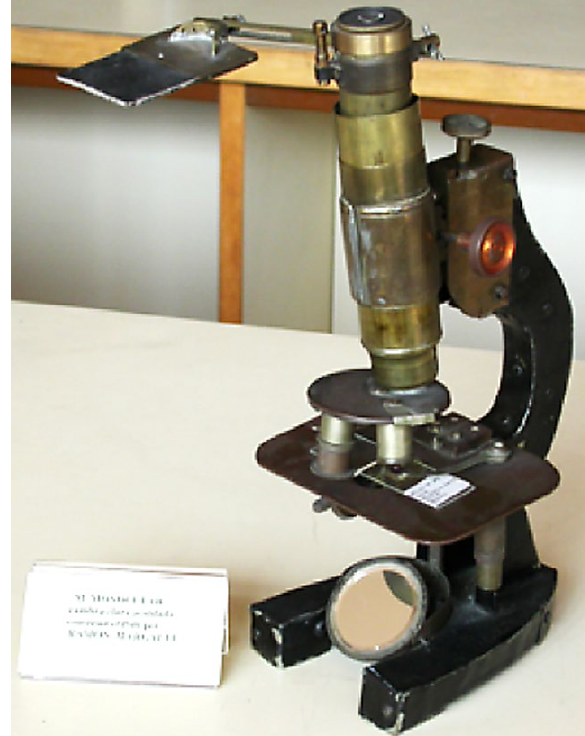
Fig. 7. – Schematic representation of the quotient productivity/bio- mass in relation to diversity corresponding to Mediterranean phyto- Fig. 8. – Margalef’s home-made microscope. The optics were ac- plankton (square limited by the dashed lines). The whole graph cor- quired in the Barcelona flea markets and the stand with the focusing responds to data for different ecosystems as described in Margalef system and the camera lucida was built by Margalef. (Photograph: (1969c). (Margalef 1970b). Margalef family